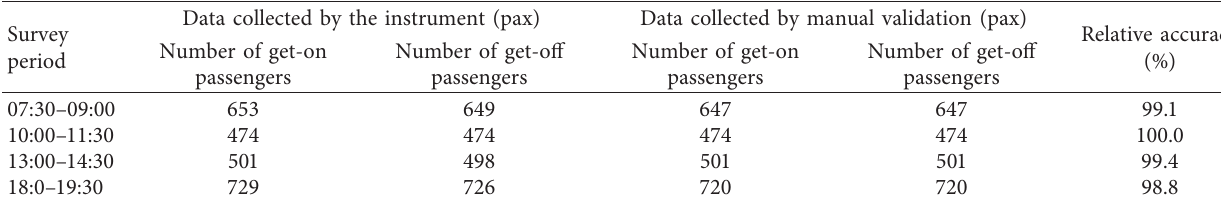
Figure 1: Passenger flow data collection system. (a) Passenger flow analyzer. (b) Binocular camera sensor. (c) Front door installation position. (d) Rear door installation position. Table 1: Statistical results of each survey period.